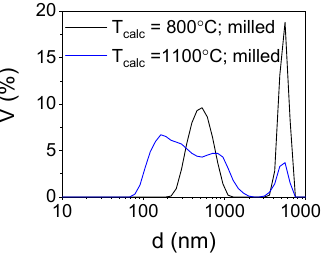
Figure 6. Particle size distribution of the milled powders.